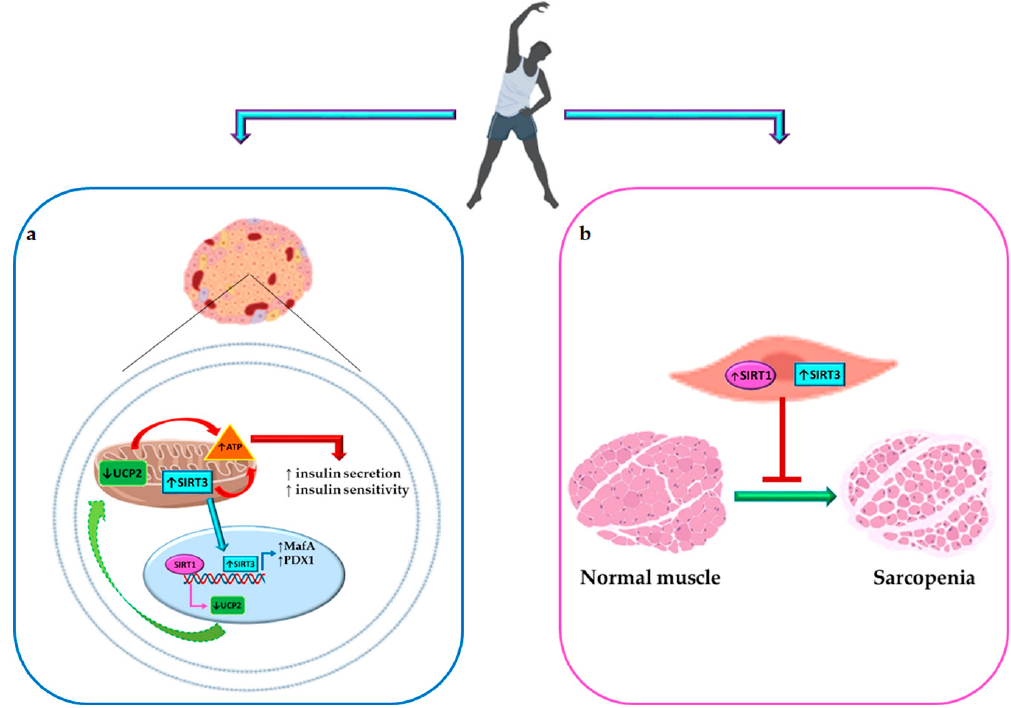
Figure 3. SIRT1- and SIRT3-mediated effects of physical activity (PA) on metabolism . ( a ) PA exerts a